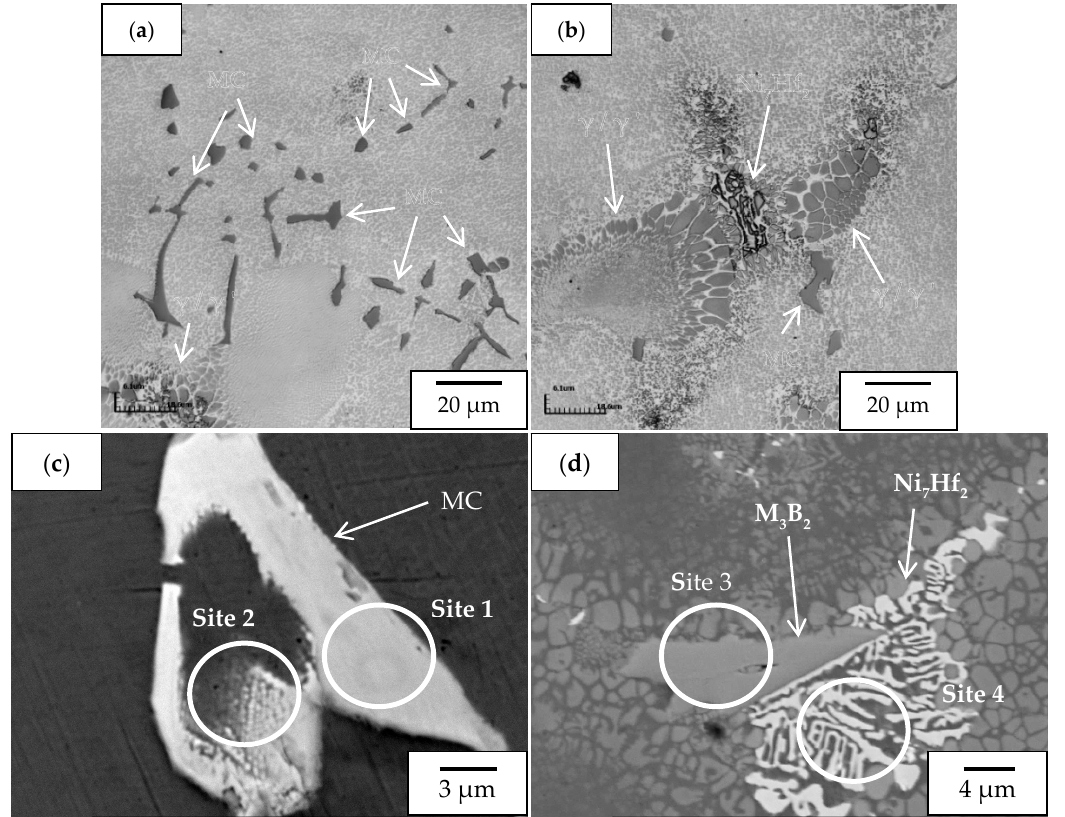
Figure 1. Optical micrographs of ( a ) MC carbides; ( b ) γ - γ′ eutectic colonies and other solidification products; BSE images of FESEM displaying ( c ) enlarged view of MC carbides; ( d ) lamellar microconstituent along boundaries. Table 1. The chemical compositions in at % of the solidification products indicated in Figure 1.